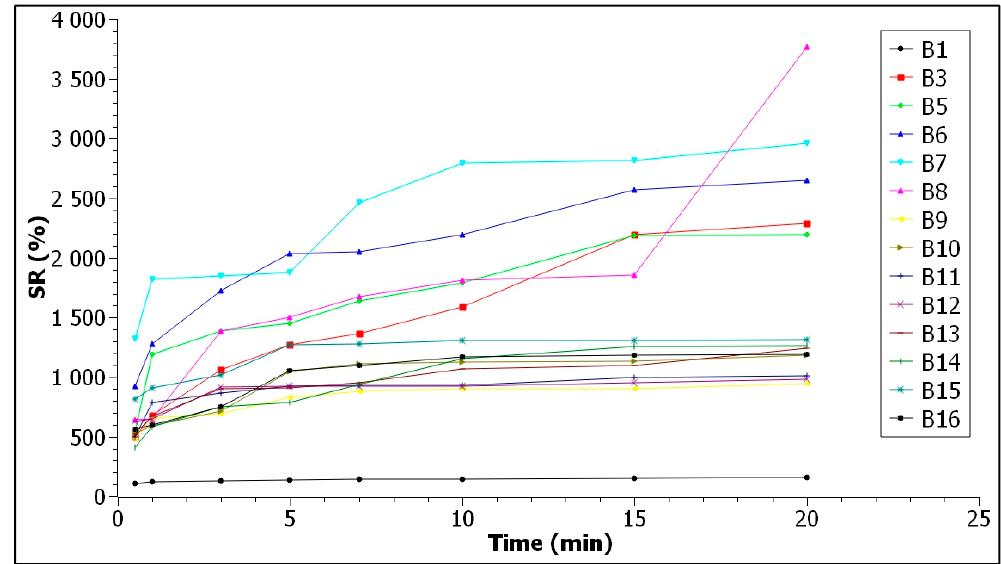
Figure 3. Swelling ratio of the films.